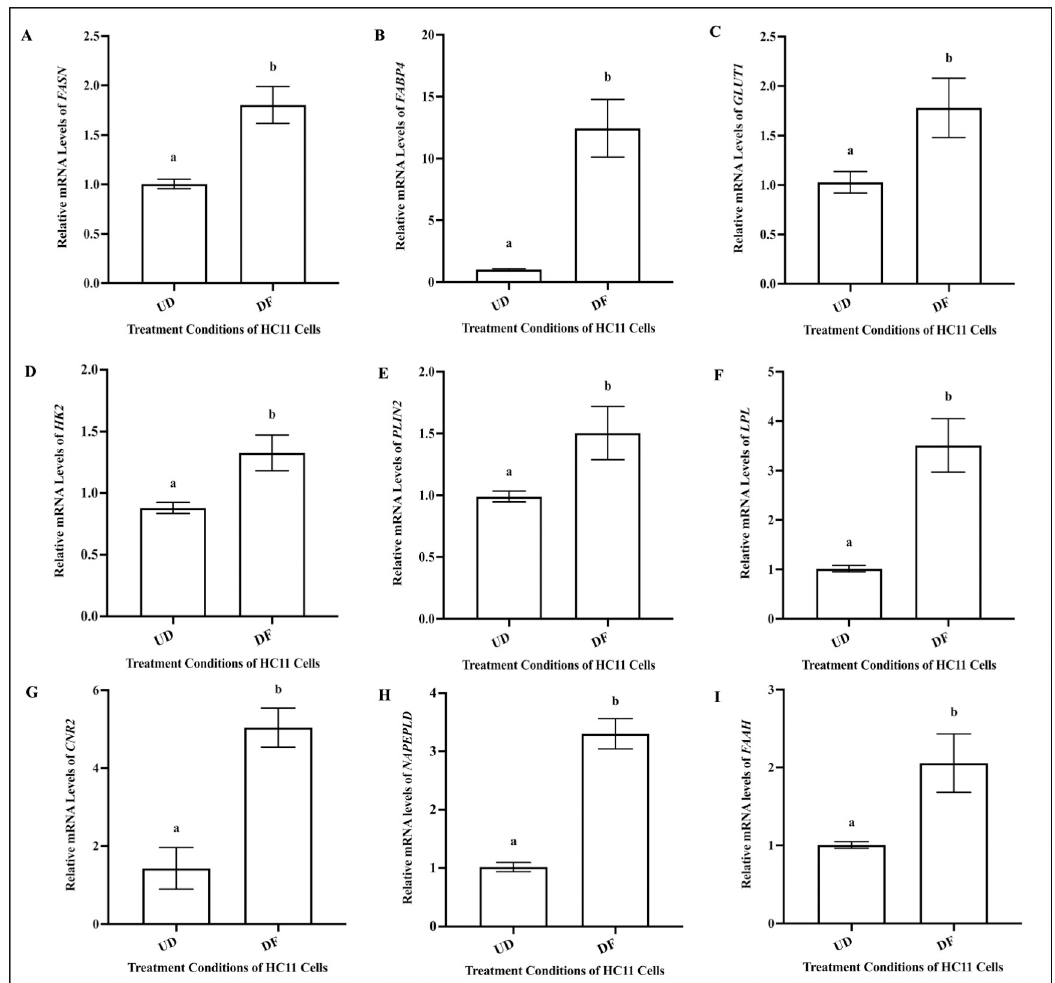
Fig 2. Differentiation increases the expression of mRNA for markers of lipid synthesis and alters mRNA levels of key ECS markers in HC11 cells. HC11 cells were seeded in base media for 24 hours (UD) and collected for RNA isolation. HC11 cells were seeded in base media for 24 hours, supplemented with EGF and INS for 3 days, and differentiated in base media containing PRL, INS and DEX 4 days (DF). Undifferentiated and differentiated cells were processed for total RNA, as described in methods. The relative mRNA levels of FASN (A), FABP4 (B), GLUT1 (C), HK2 (D), PLIN2 (E), LPL (F), CNR2 (G), NAPE-PLD (H ) and FAAH (I) were determined. Gene expression analysis was repeated with 6 distinct replicates. Results were represented as mean ± SEM and compared using a t-test. Statistically significant changes were represented by distinct letters on the bar